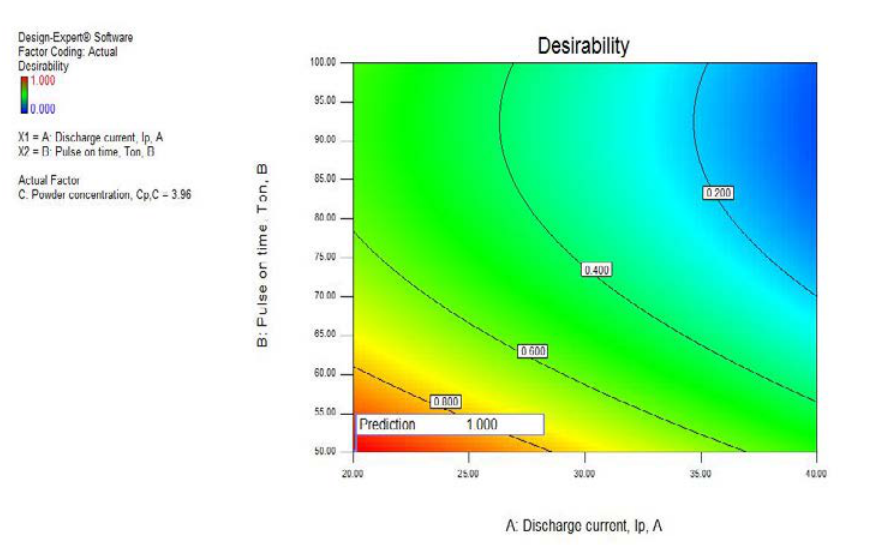
Figure 8: Contours for solution desirability